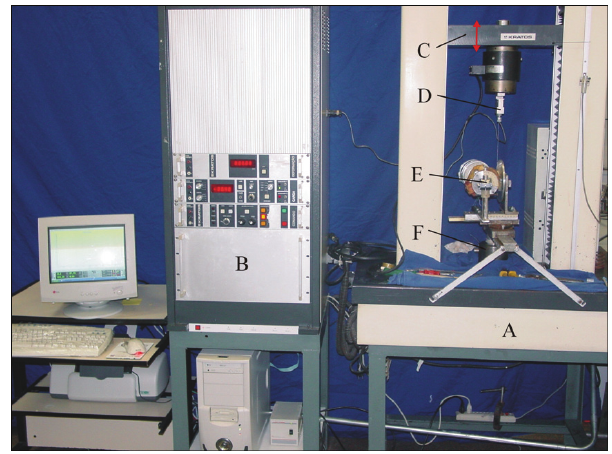
Figure 3 - KRATOS® testing machine used for the biomechanical study. A. Mechanical testing device. B. Data acquisition system. C. Testing machine pivo (arrow indicates direction of movement). D. Load cell (100 kgf). E. Knee fixed to the device. F. Base image of the knee fixed to the device.